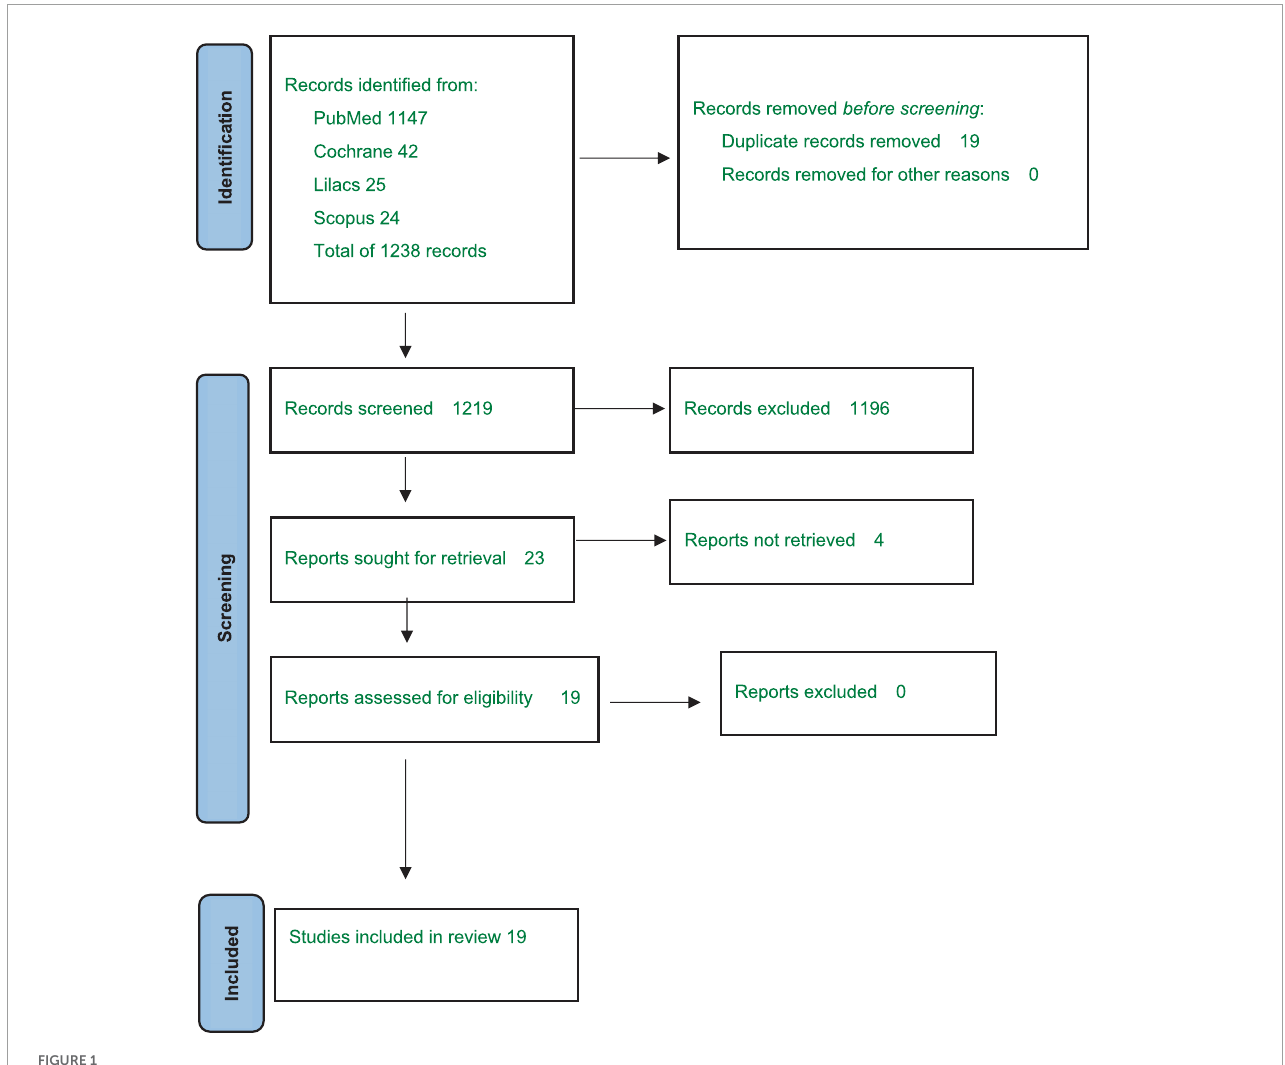
FIGURE1 Flow diagram of the studies’